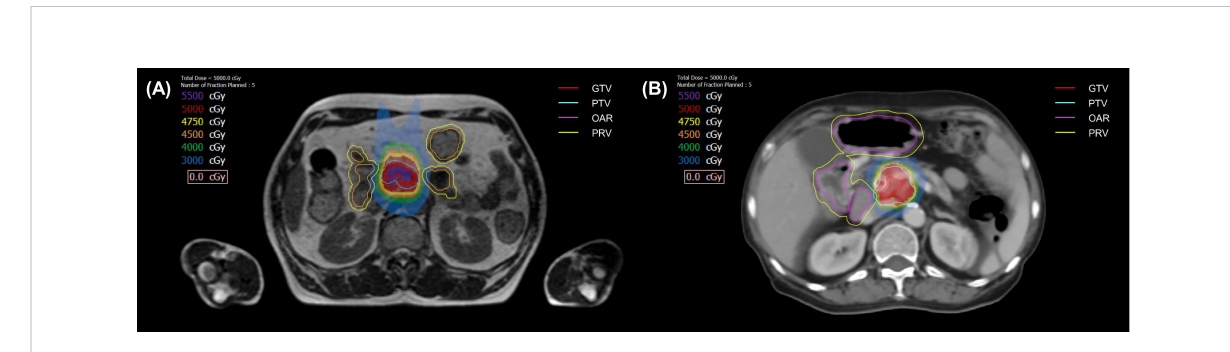
FIGURE 2 The target volumes and isodose lines for patients prescribed 50 Gy in 5 fractions with magnetic resonance-guided adaptive radiotherapy (A) , and linac- based nonadaptive radiotherapy (B) . GTV, gross tumor volume; PTV, planning target volume; OAR, organ at risk; PRV, planning OAR volume.